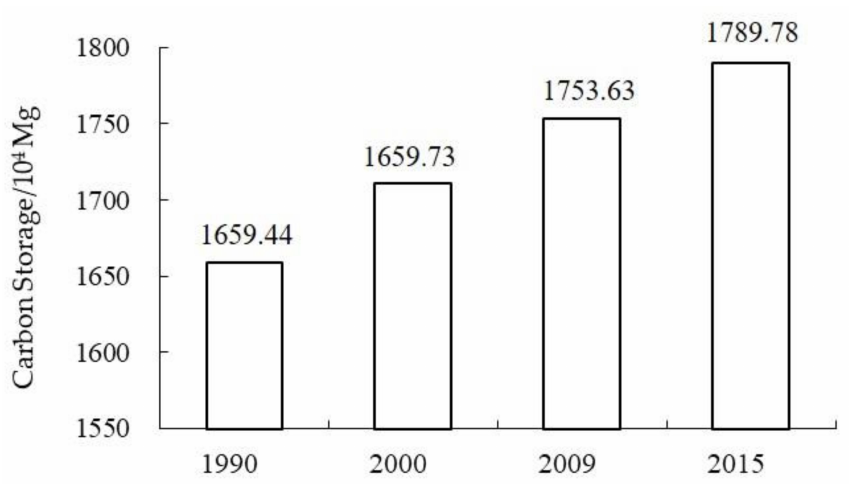
Figure 3. The dynamics of blue carbon storage in the Shanghai coastal area during 1990–2015.